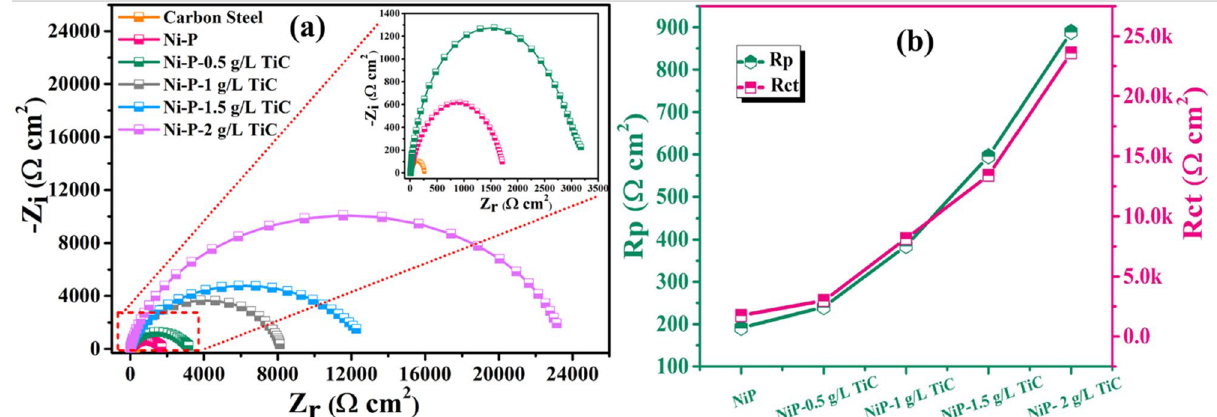
Figure 14. ( a ) Nyquist plots for carbon steel (substrate) and Ni–P–TiC composite coatings along with fitted resistance values vs. the concentration of TiC particles after the 2 h of immersion in 3.5wt% NaCl solution ( b ) evolution of R po and R ct with the TiC particles